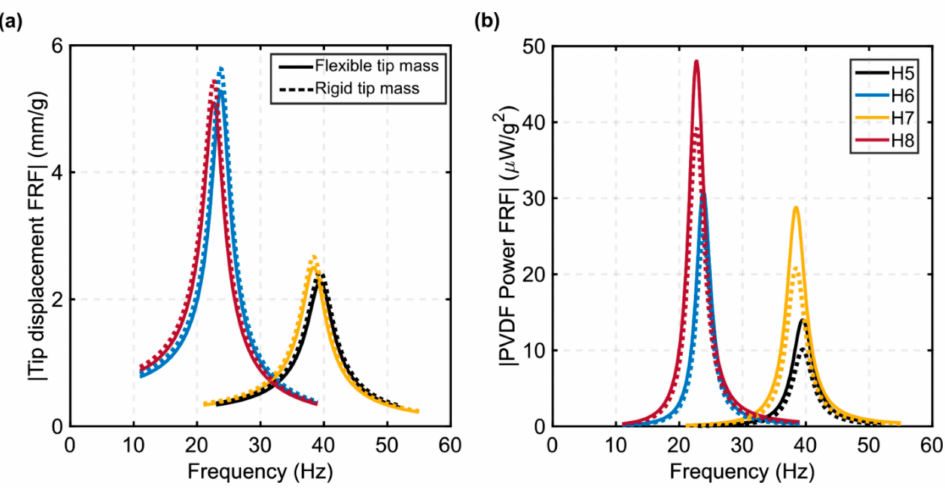
Figure 8. Flexible vs. rigid tip mass model predictions for harvesters with solar panels. ( a ) Tip displacement frequency response function. ( b ) PVDF power frequency response function. Solid lines represent flexible tip mass model whereas dashed lines represent rigid tip mass model.